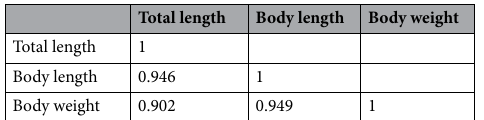
Table 1. Pearson correlation coefficients (r) for all pairwise combinations of the three growth-related traits ( P < 0.01 for all).